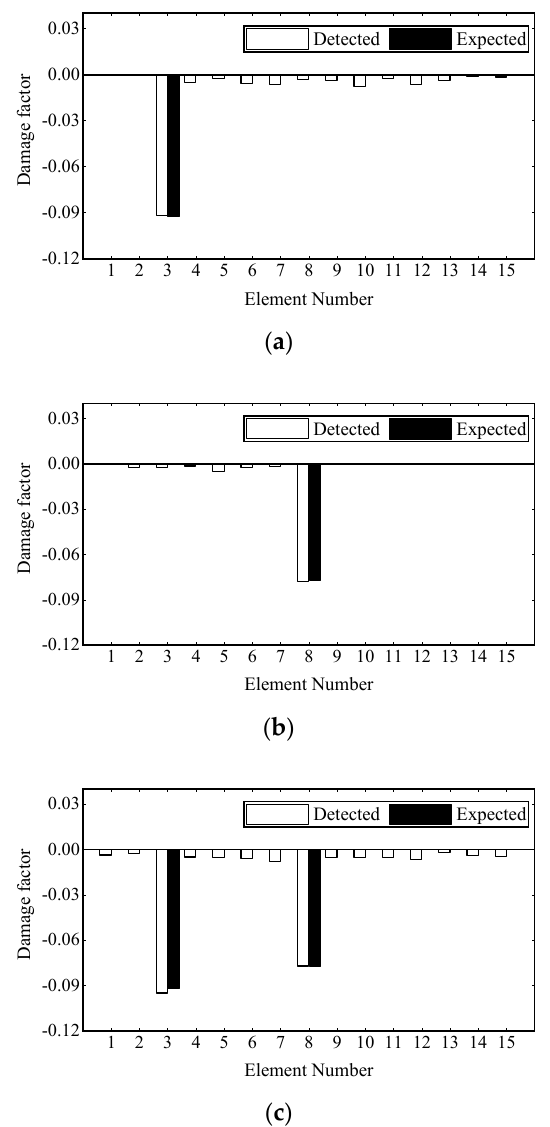
Figure 5. Damage identification results under stochastic excitation: ( a ) scenario 1; ( b ) scenario 2; ( c ) scenario 3.